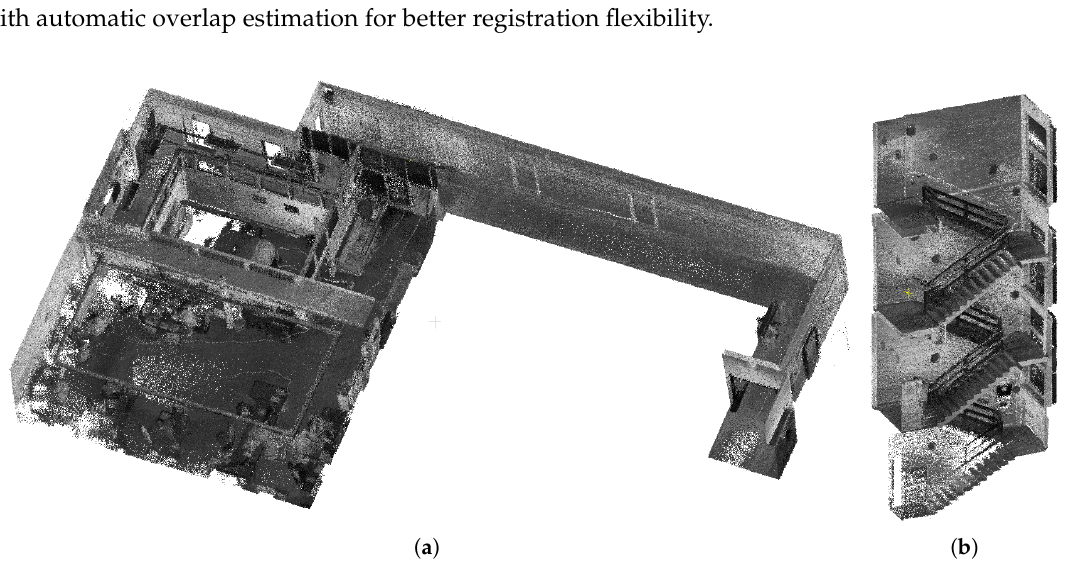
Figure 2. The example of resulting models of indoor mapping. The office environment ( a ) and the staircase ( b ) were captured by a human carrying our 4RECON backpack. The data acquisition process took 3 and 2 min,